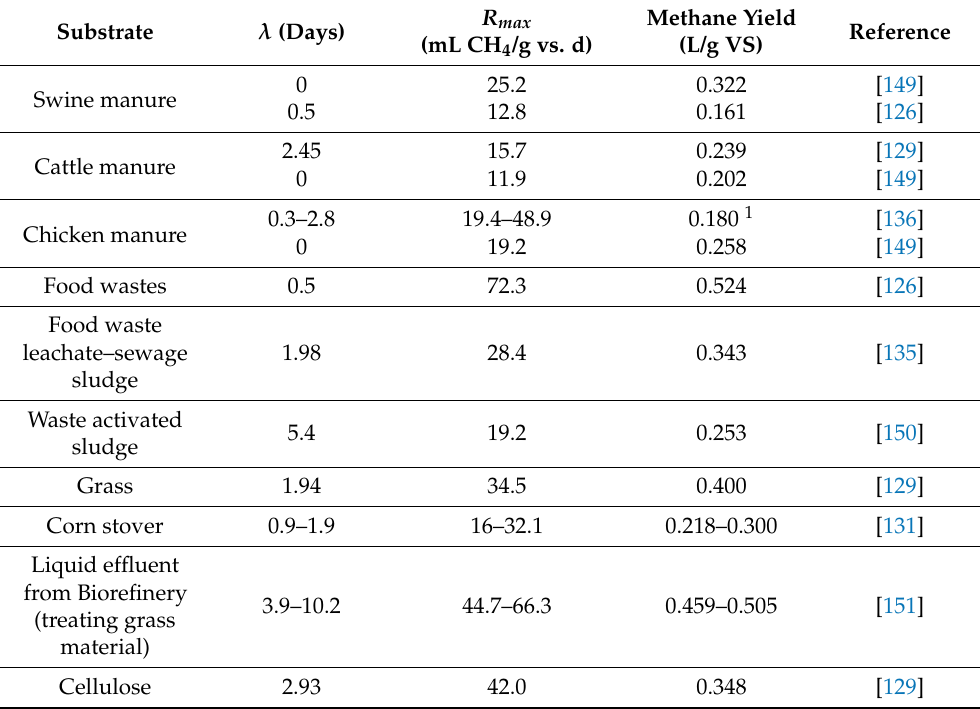
Table 3. Values reported in the literature for different substrates under mesophilic conditions regard- ing kinetic parameters from the Gompertz model.